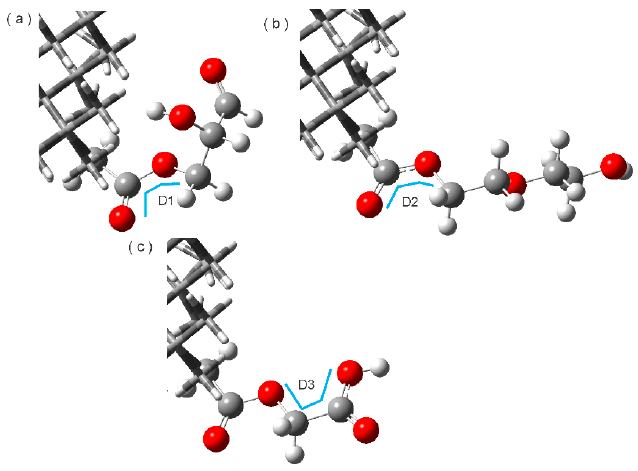
Figure 2. Dihedral D1, D2, and D3 in ( a ) ND2HP; ( b ) NDPEG; and ( c ) NDPGA.